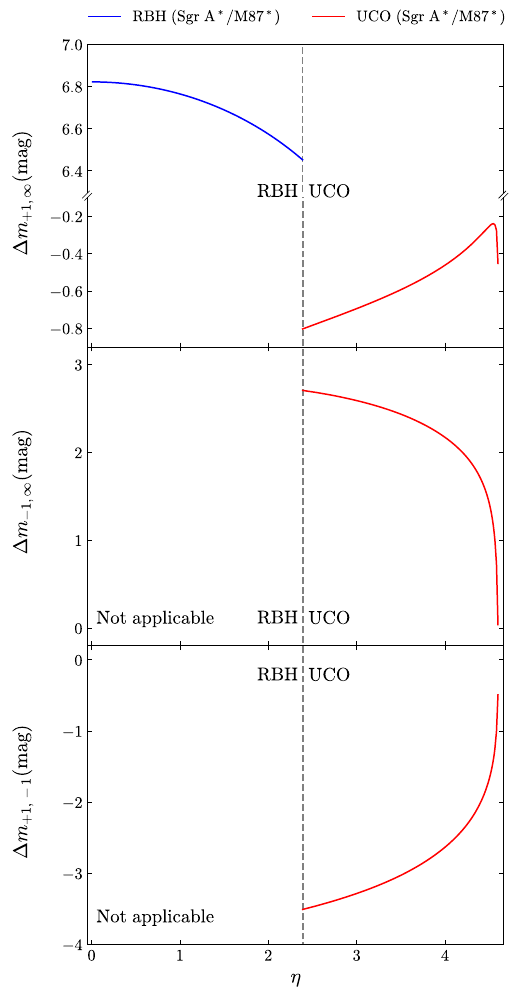
Fig. 5 The brightness differences (cid:14) m + 1 , ∞ , (cid:14) m − 1 , ∞ and (cid:14) m + 1 , − 1 with respect to η for an Einstein–Lovelock regular black hole and for an Einstein–Lovelock ultracompact object in the cases of SgrA* and M87*